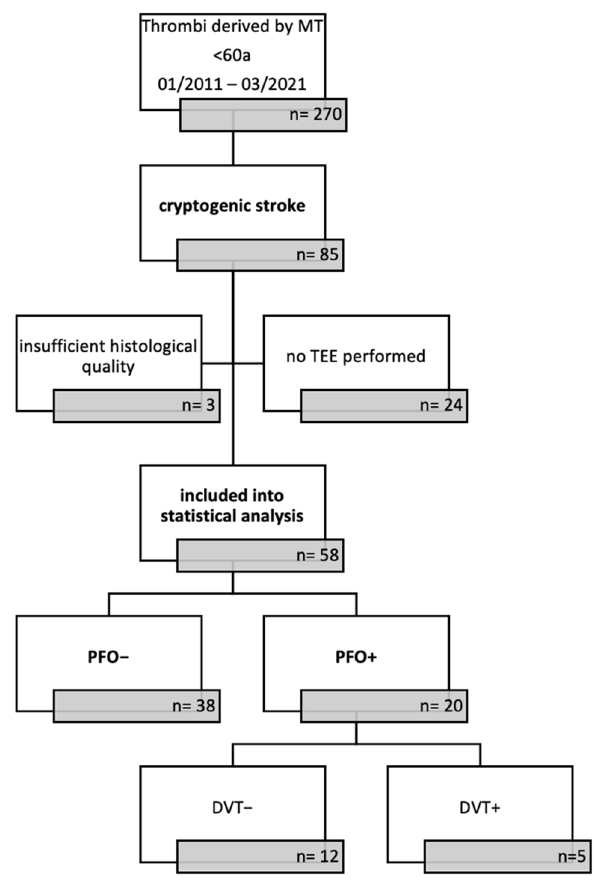
Figure 4. Study flow chart. Graphic depiction of patient selection criteria and division of study pop ‐ ulation. The study population was primarily divided according to the presence or absence of a pa ‐ tent foramen ovale (PFO+, PFO–). We secondarily divided the PFO+ patients based on the presence of a deep vein thrombosis (DVT+, DVT–), as assessed by sonography. DVT screening was not per ‐ formed in three cases. a = years of age, MT = mechanical thrombectomy, TEE = transoesophageal